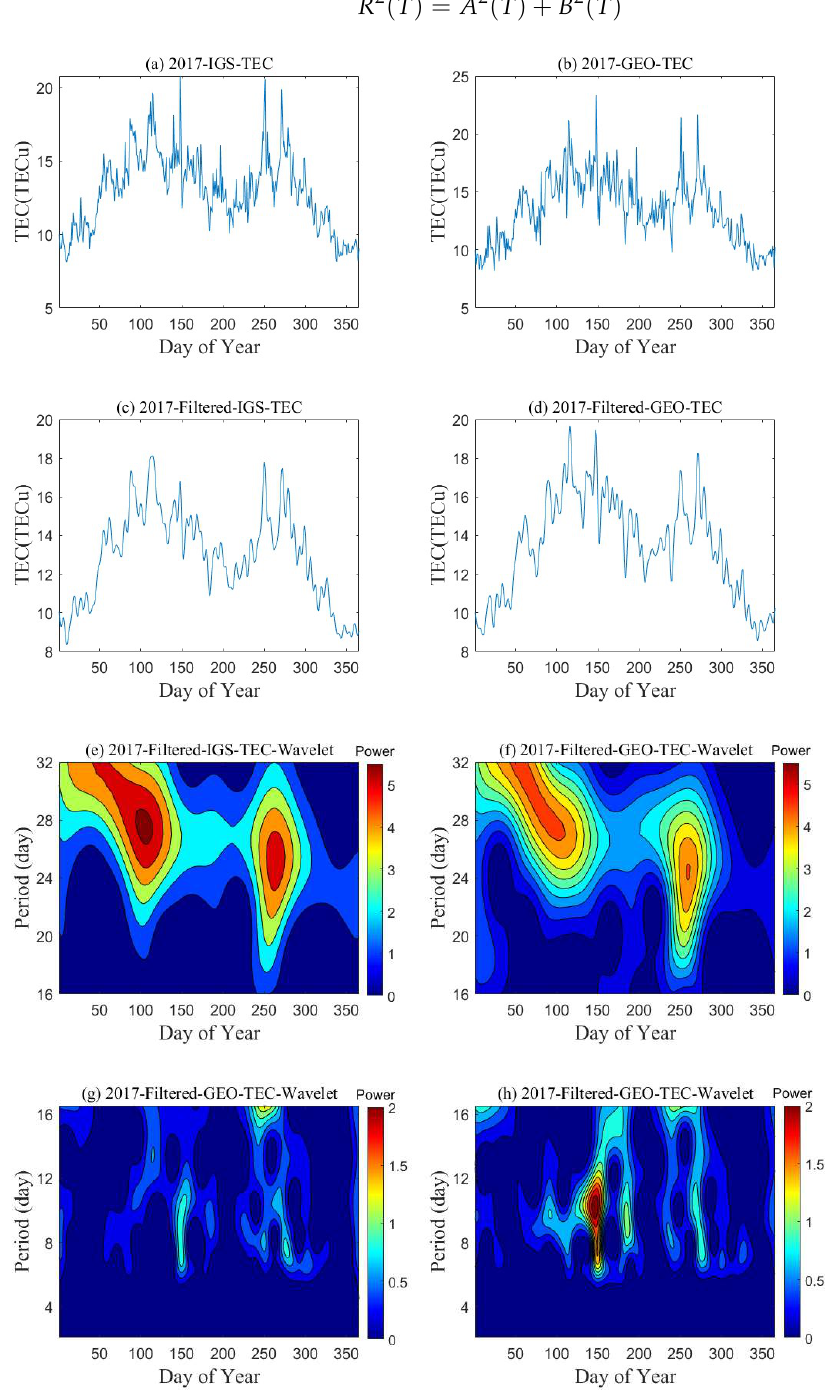
Figure 1. ( a , b ) The original data from IGS (Beidou GEO)-TEC during 2017. ( c , d ) The filtered IGS (Beidou GEO)-TEC data during 2017 after filtering by the low-pass filter. ( e , f ) Wavelet spectrums of the filtered IGS (Beidou GEO)-TEC during 2017 with a period range of 16–32 days. ( g , h ) Same as ( e , f ), but the period range is 0–16 days.